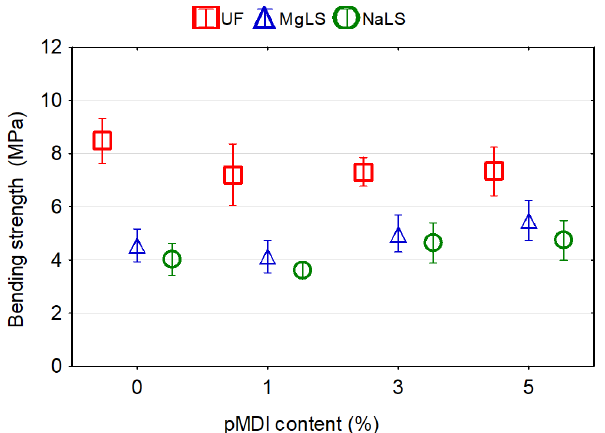
Figure 10. Effect of pMDI content on the IB of particleboards bonded with pure UF and lignosul- fonate adhesives.